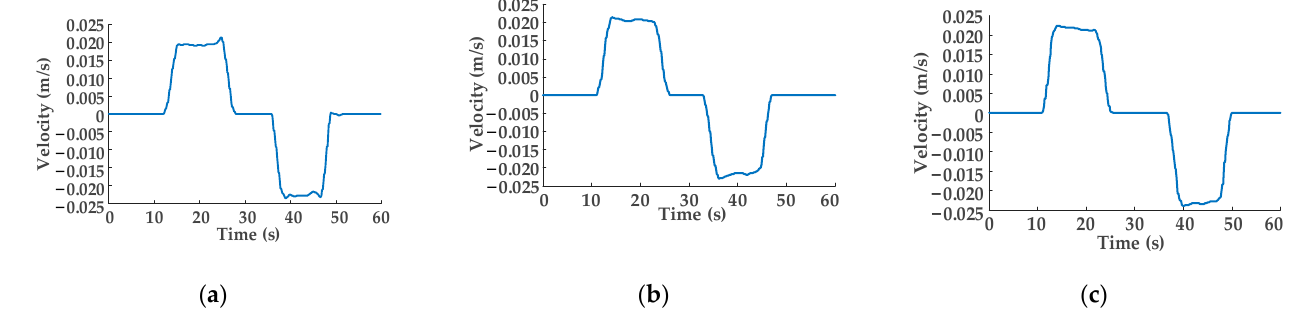
Figure 10. Speed variation curves of the hydraulic cylinder piston rod: ( a ) output pressure of the constant-pressure variable pump is 7 MPa; ( b ) output pressure of the constant-pressure variable pump is 6 MPa; ( c ) output pressure of the constant-pressure variable pump is 5 MPa.